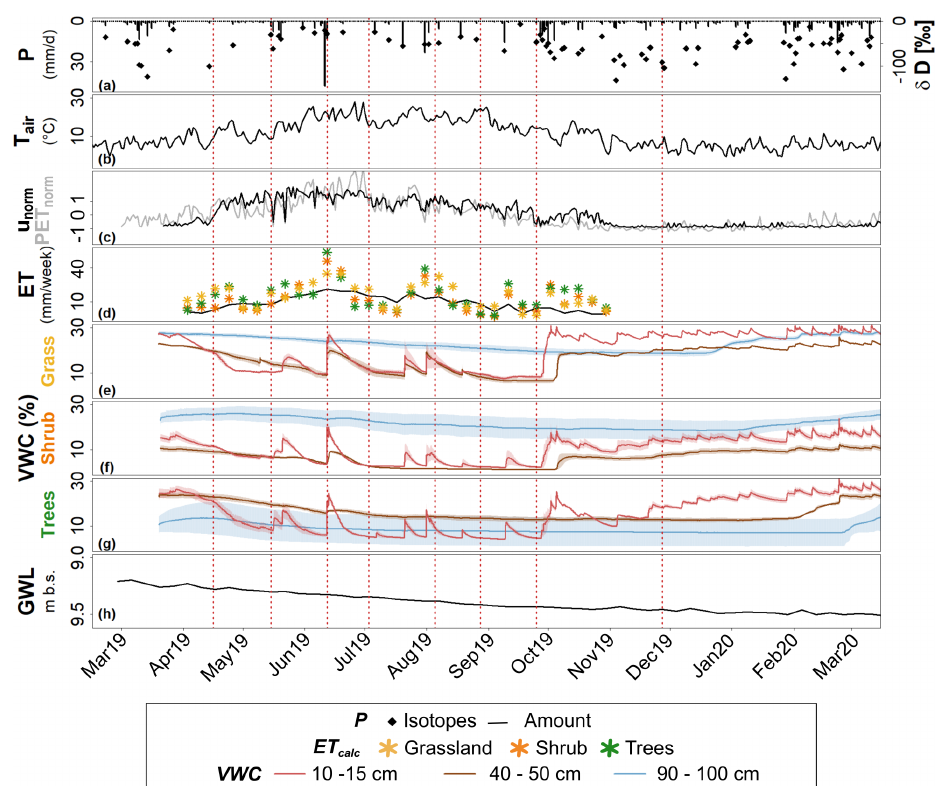
Figure 2. (a) Daily P sums (DWD, 2020a) and isotopic composition, (b) mean daily T air (DWD, 2020a), (c) daily u norm and PET norm (grey) (d) weekly ET calc and ET of the eddy flux tower (grey line), (e–g) soil VWC at different depths and sites and (h) mean weekly groundwater level (GWL) near the SUEO (SenUVK, 2020). Dashed red lines mark the days on which soil samples were taken for monthly soil water isotope